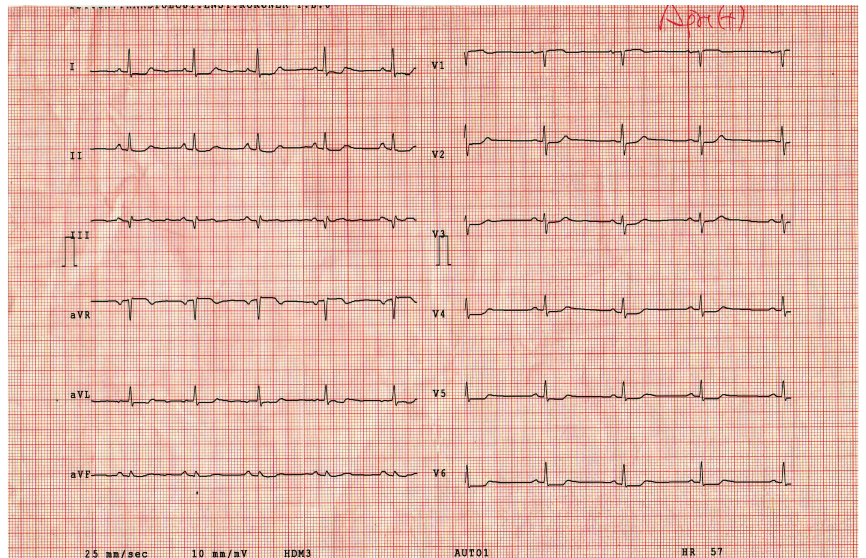
Figure1:OnemmSTdepressionintheleadsD2,D3,aVF,V4,V5,andV612onelectrocardiographyofthepatientperformedattheEmergency Service.